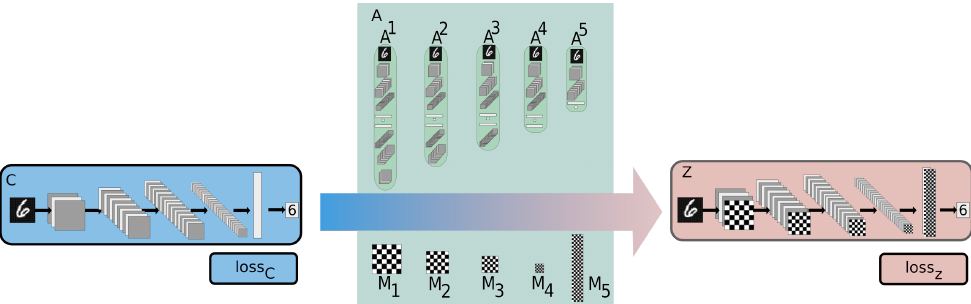
Figure 1. Example of the proposed method. The auxiliary network ensemble A , comprising networks A 1 , A 2 , . . . , A k , k ∈ 0,1,2, . . . , L C , is responsible for providing each layer of network C with a binary mask M k , which controls which parts of the l C layer will be trained. The applied masks’ performance j is evaluated on the next forward pass, and, if the proposals are accepted, the training procedure continues with the modified version of C , Z